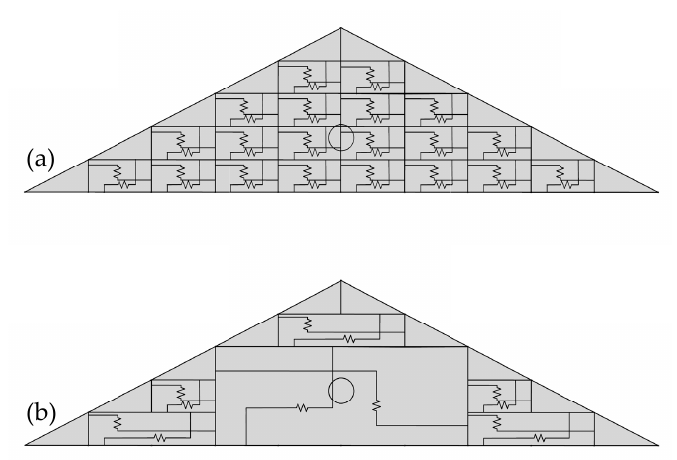
Figure 15. Macro model representation of timber folded plate surfaces; ( a ) refined models; ( b ) practical models.